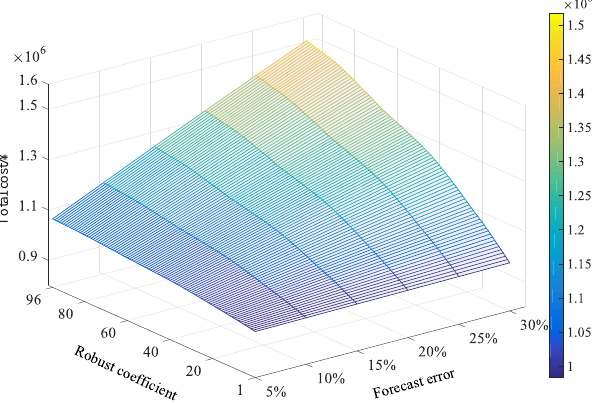
Figure 11. Relationship between total cost and prediction error and conservatism.